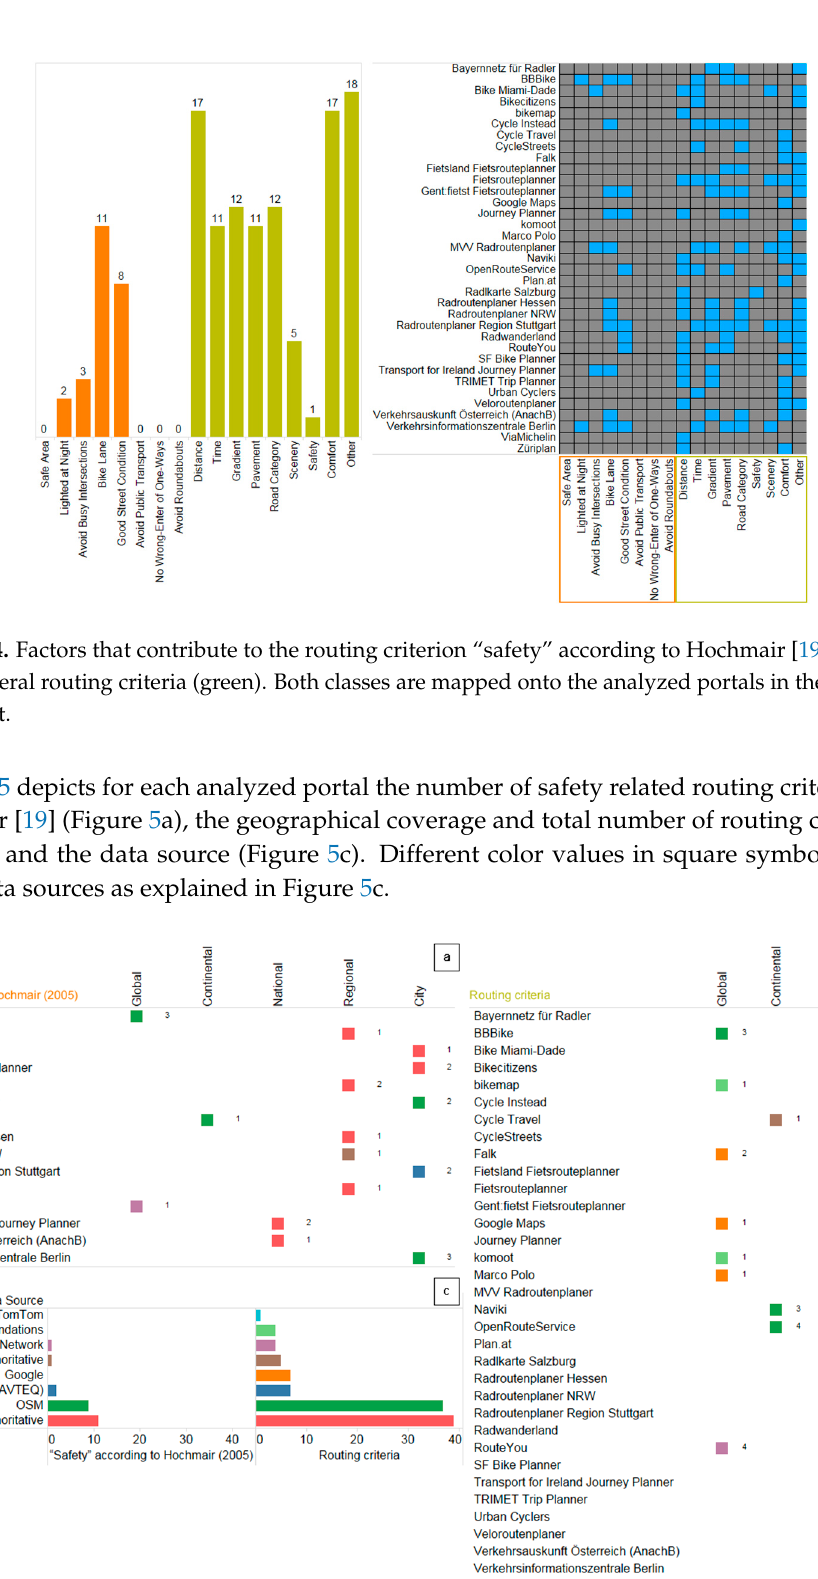
Figure 5. Analyzed bicycle routing portals: Number of safety related routing criteria per portal ( a ); geographical coverage and total number of cycling related criteria per portal ( b ); and data sources ( c ).